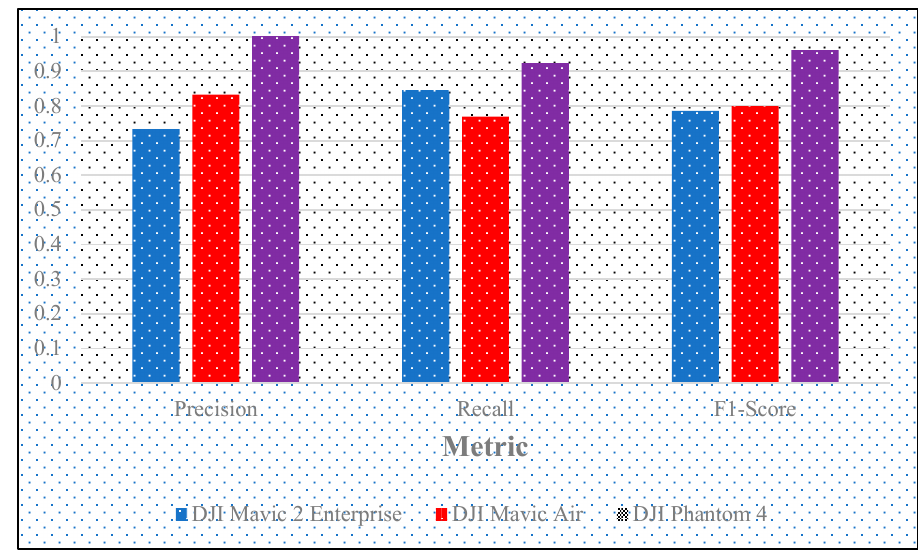
Figure 6. Per Class Metrics for Prediction of Test Images Using Trained Resnet-18 Model.